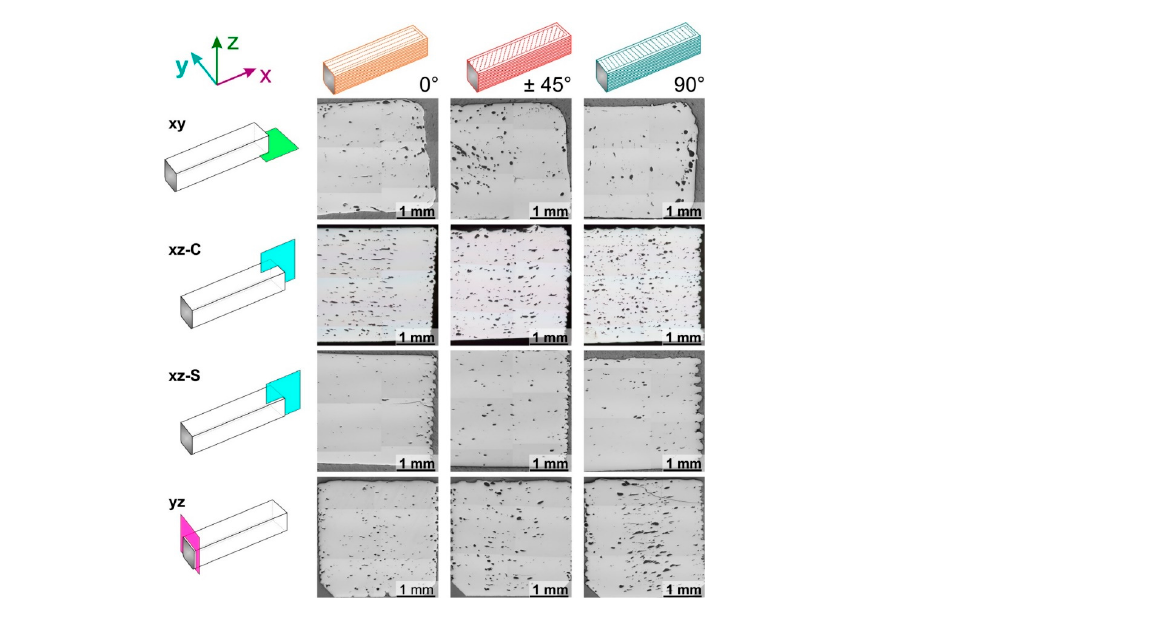
Figure 6. Sections of sintered fractured bars with the three infill patterns. The location and orientation of the imaged plane are indicated in the leftmost column with the directions parallel to the plane used to designate it. The zones studied are the center (C) or the side (S). The fracture surface is marked with a dark gray color in the schematic representation.